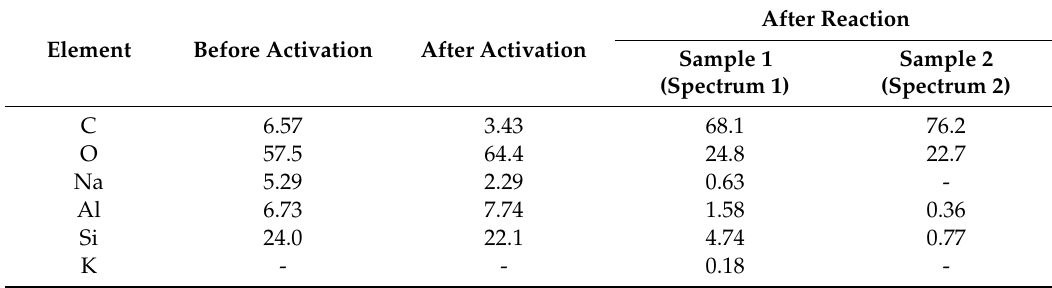
Table 8. Atomic percent data obtained by EDS spectra for catalyst samples, before and after the activation processes, as well, after the biomethane reaction, at 300 ◦ C with 4% ( w / w ) of zeolite HY. Element Before Activation After Activation